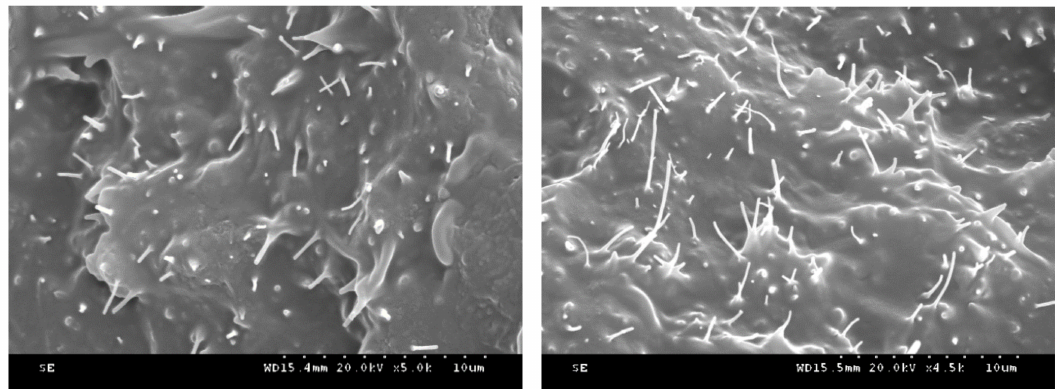
Figure 8. SEM images of different parts of CP1.6 CNFPUC hexahedron.